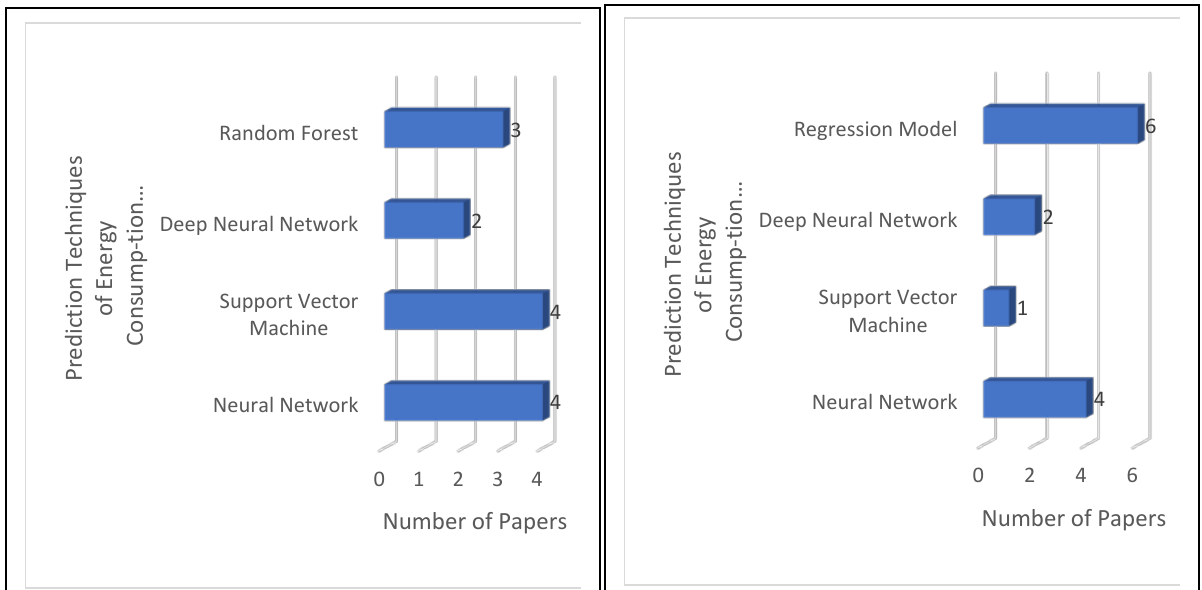
Figure 10. Prediction techniques that used energy consumption in residential and public buildings.